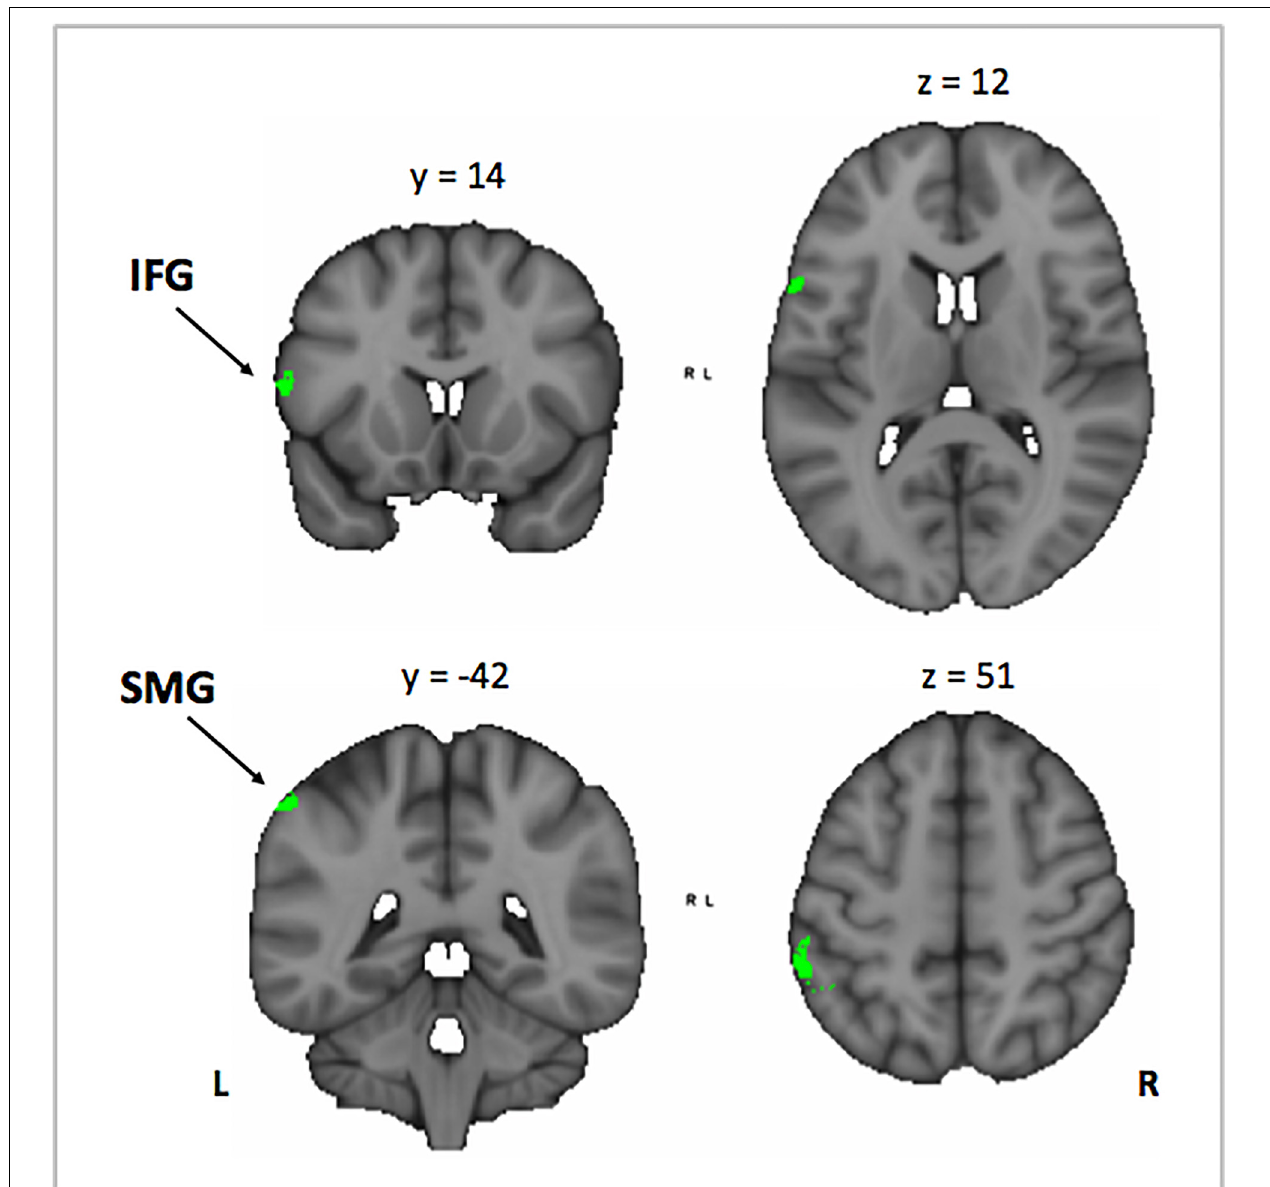
FIGURE 7 | Conjunction analysis between the Mus > Cont contrast of the correlation between the activation in the encoding phase [VSA > P] contrast with the correct responses of each subject in the auditory memory tasks of the VSA condition trials, and the correlation between the years of musical training in the musically trained group in the encoding phase [ASA > P] contrast. Mus, musically trained children; Cont, control children; VSA, visual selective attention; ASA, auditory selective attention; P, passive. IFG, inferior frontal gyrus; SMG, supramarginal